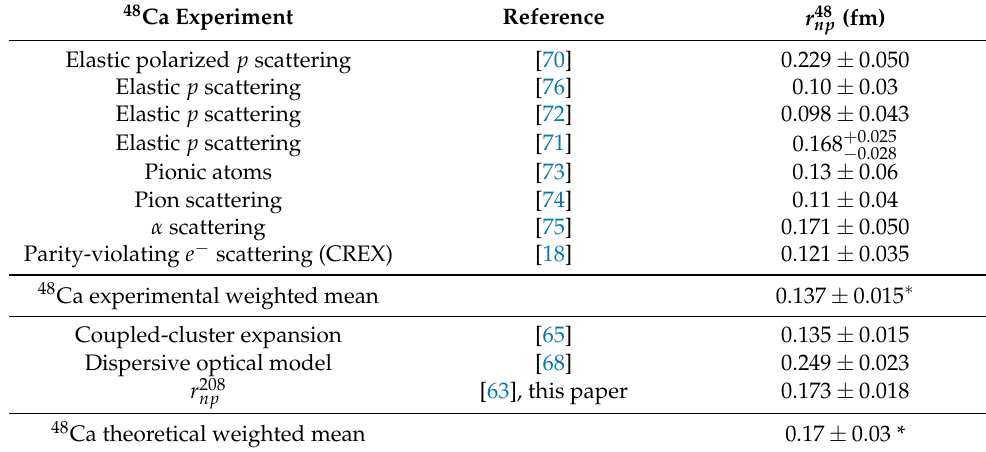
Table 5. 48 Ca neutron skin measurements and theoretical predictions with 1 σ uncertainties. ∗ Uncer- tainty scaled upwards as per Ref.